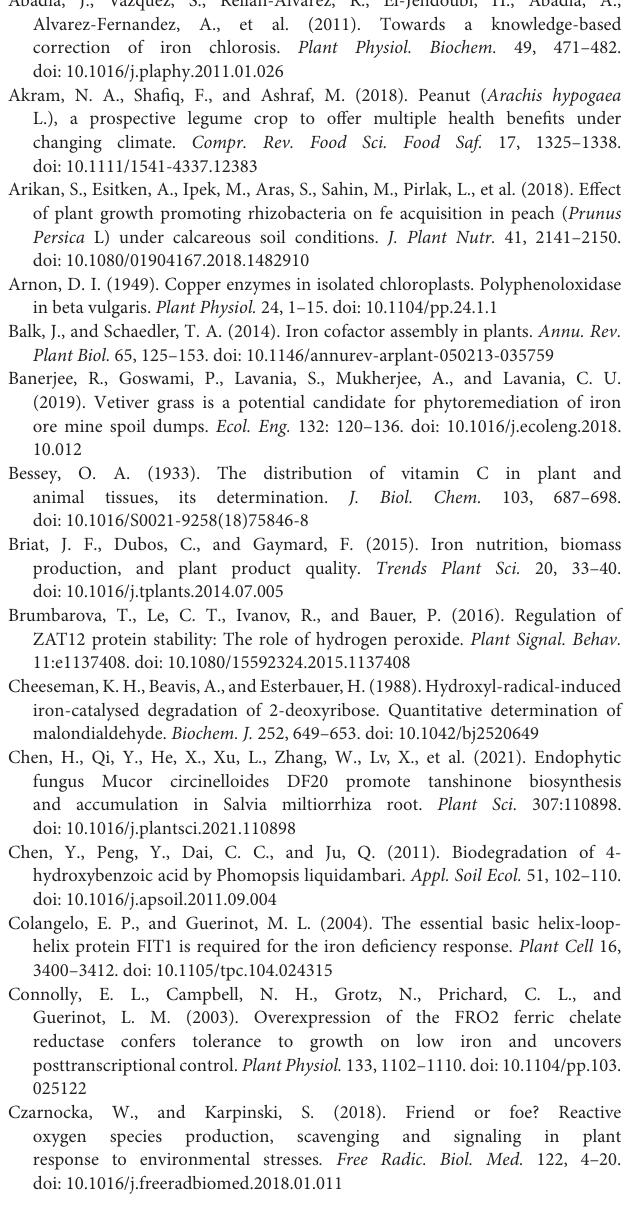
Supplementary Figure 6 | Colonization of P. liquidambaris in different treatment groups. The peanuts were transferred to the Hoagland nutrient solution. Seven days later, the colonization was detected by q-PCR. The data shown are the mean ± SD. E = P. liquidambaris inoculation . -Fe = 2 µ mol FeEDTA in Hogland nutrition. CK = 100 µ mol FeEDTA in Hogland nutrition. Supplementary Figure 7 | GO and KEGG pathway enrichment analysis based on the differentially expressed genes between Fe-sufficient and Fe-deficient peanut roots with or without P. liquidambaris. (A) : Go analysis between CK and -Fe. (B) : Go analysis between CK and E. (C) : Go analysis between -Fe and E-Fe. (D) : KEGG analysis between CK and -Fe. (E) : KEGG analysis between CK and E. (F) :